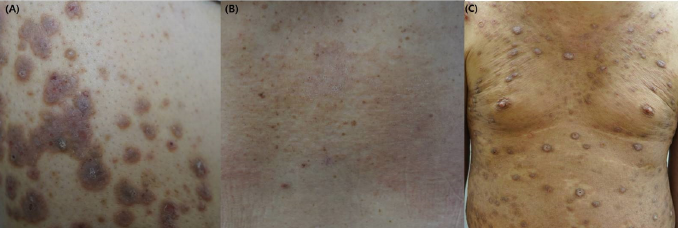
Figure 1. The clinical images of patients with CKD-associated pruritus ( A ) Multiple excoriated, purple-colored nodules or plaques on the back. ( B ) Scaly, erythematous patches on the back. ( C ) Multiple excoriated, dome-shaped nodules on the trunk.